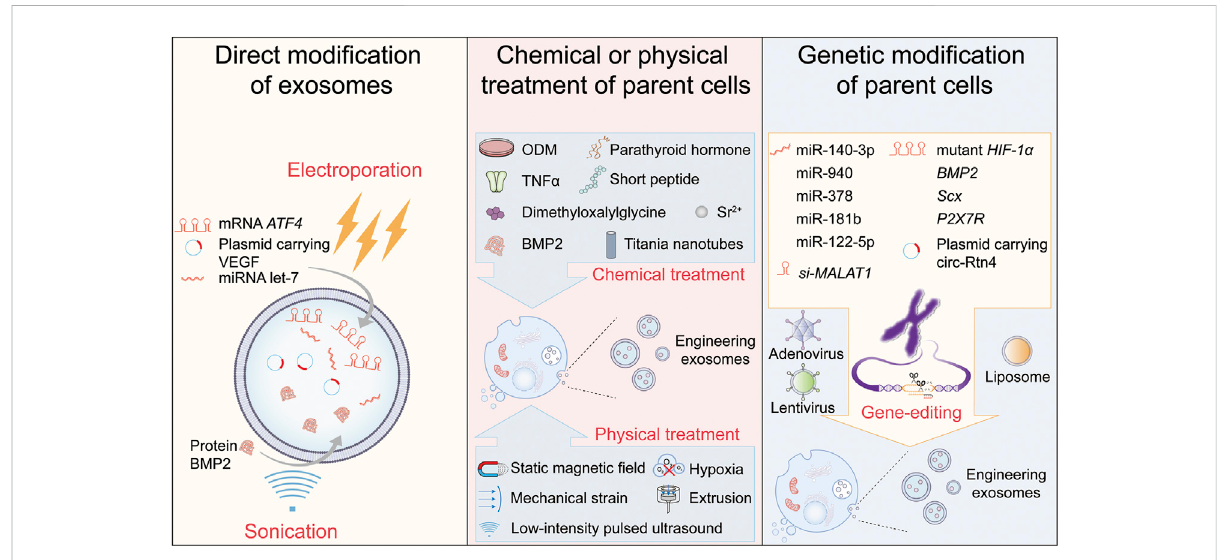
FIGURE 2 Three strategies of engineering exosomes for bone regeneration. ODM: osteogenic differentiation